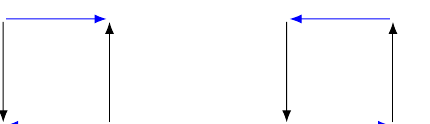
Figure 6. The graph of coordination (left) and its reflection in player 2, which is the graph of Matching Pennies (right). Note that reflecting the game in the preferences of player 1 swaps between the same two